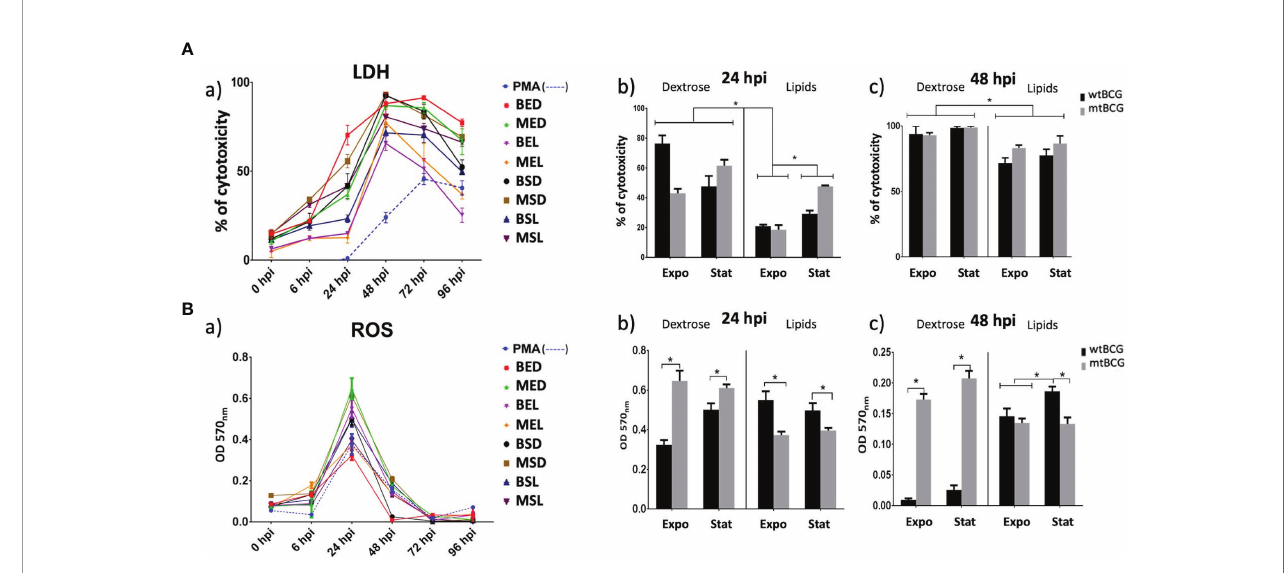
FIGURE 8 | Cytotoxic effect on THP-1 macrophages induced by M. bovis BCG strains. THP-1 macrophages (5 × 10 5 ) were infected with wtBCG or mtBCG strains using a MOI of 5:1. Cytotoxic effect was measured by (Aa) LDH activity released from the cytosol of damaged macrophages and (Ba) reactive oxygen species production (ROS) in a 96-h kinetic. Signi fi cant changes in LDH activity (Ab, c) as well as variations in the ROS production (Bb, c) are shown at 24 and 48 hpi. In both LDH and ROS experiments, a positive control of cells in the presence of 100 nM PMA (dotted line) was used. All experiments were performed in triplicate using wtBCG or mtBCG cultured in dextrose or lipids during the exponential phase (BED, wtBCG dextrose; BEL, wtBCG lipids; MED, mtBCG dextrose; MEL, mtBCG lipids) or the stationary phase (BSD, wtBCG dextrose; BSL, wtBCG lipids; MSD, mtBCG dextrose; MSL, mtBCG lipids). *, p <